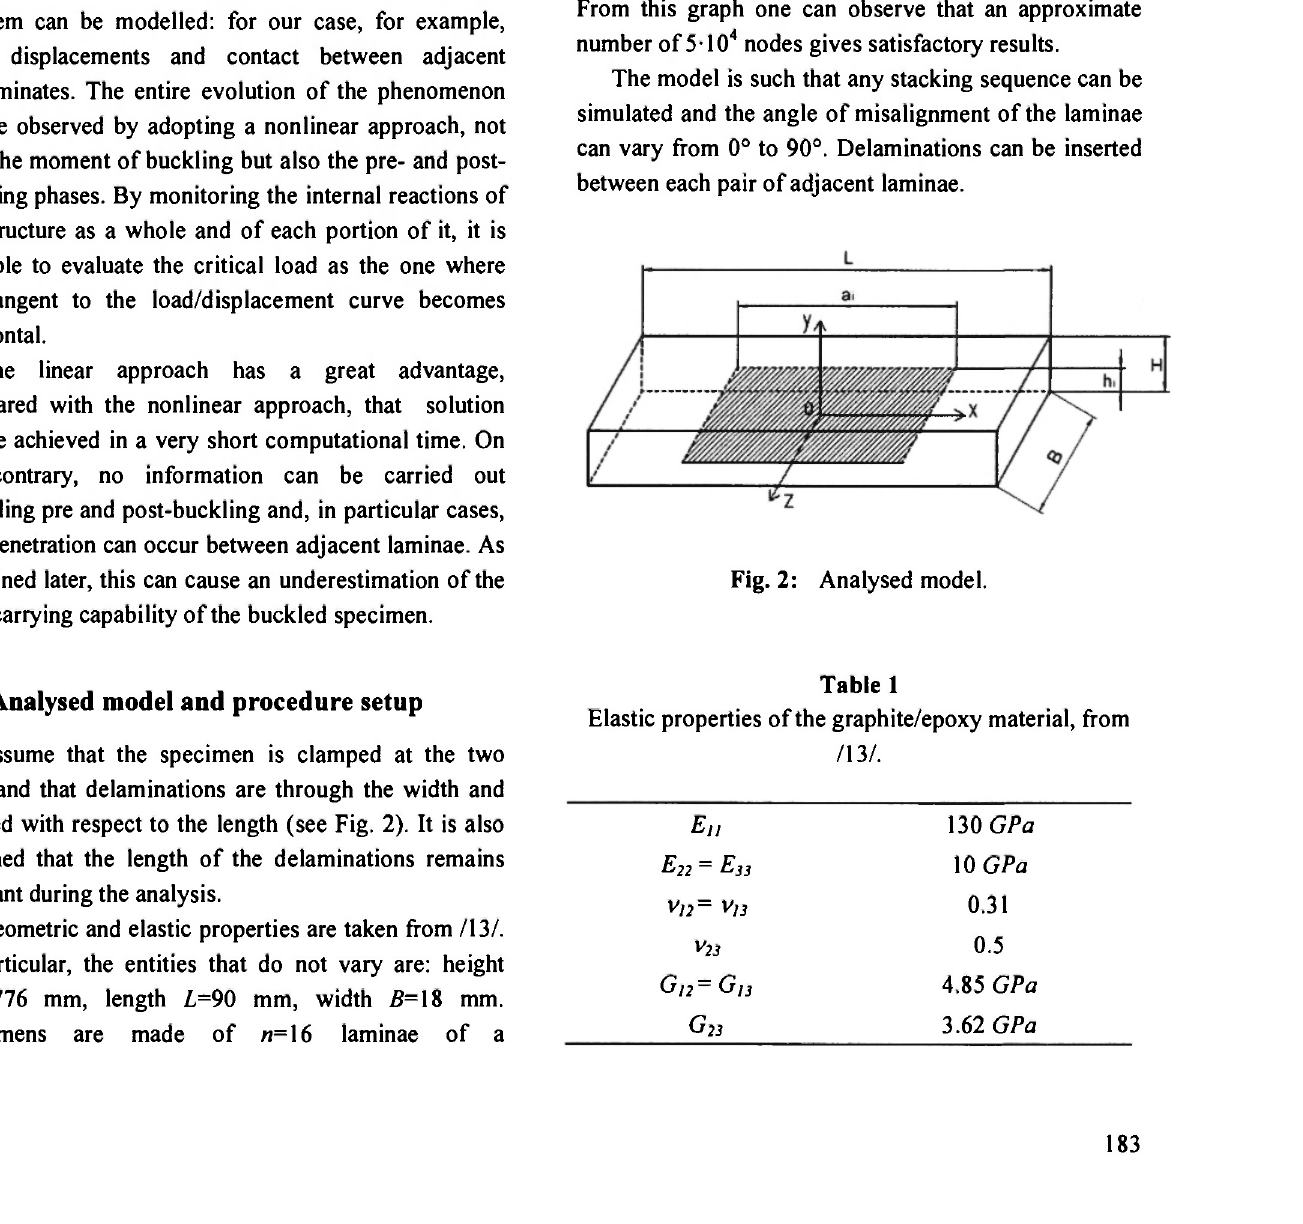
Elastic properties of the graphite/epoxy material, from